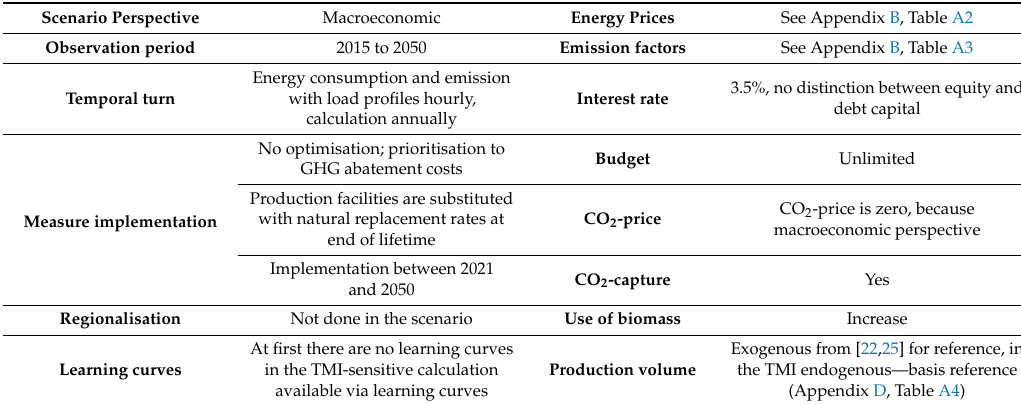
Table 1. Overview scenario Technology Mix Industry